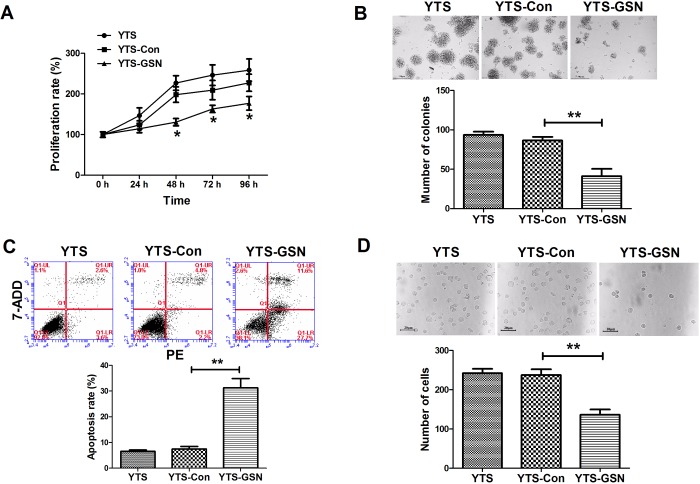
GSN overexpression inhibits proliferation, colony formation and invasion of YTS cells and promotes apoptosis. (A) CCK-8 assays revealed that GSN overexpression inhibited YTS cell proliferation. (B) Representative photomicrographs of colony formation assay of YTS cells transfected with lenti-Con and lenti-GSN plasmids for 12 days are shown. Statistical analysis of colony formation assay showed that GSN overexpression caused a decrease in the clonogenic survival of YTS cells compared with YTS-Con cells. (C) Representative photomicrographs of flow cytometric analysis are shown. Statistical analysis of flow cytometric analysis showed that GSN overexpression significantly increased the apoptosis rate in YTS cells at 48 h. The apoptosis rate was the sum of the late apoptosis in the first quadrant and the early apoptosis in the fourth quadrant. (D) Representative photomicrographs of transwell invasion assay in cells at 48 h. Statistical analysis showed that GSN obviously suppressed YTS cell invasion. **P<0.01.